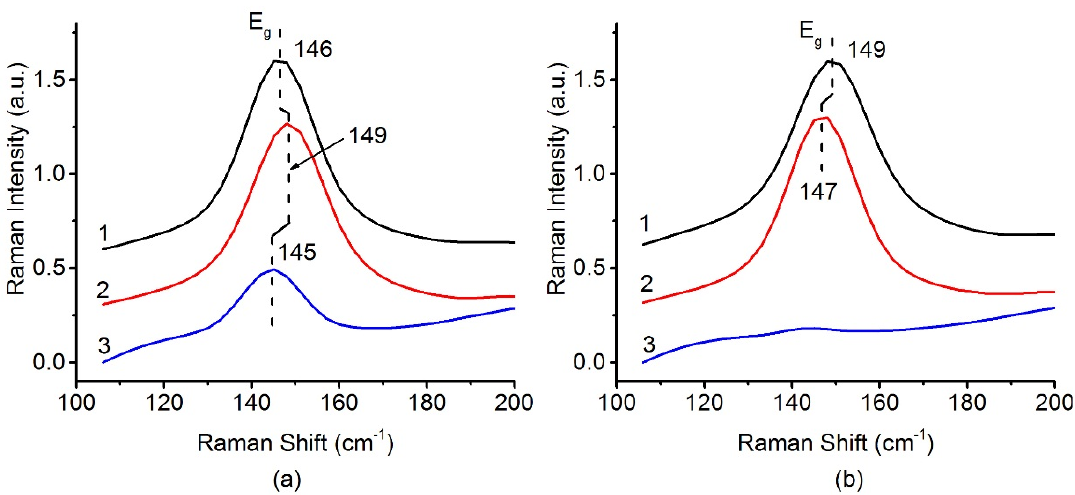
Figure 5. Raman spectra in range 100–200 cm − 1 for (a) Pt/Ti-PLA and (b) Pt/Ti-P25 catalysts, calcined at 400 ° С (1), 600 ° С (2) and 800 ° С (3).